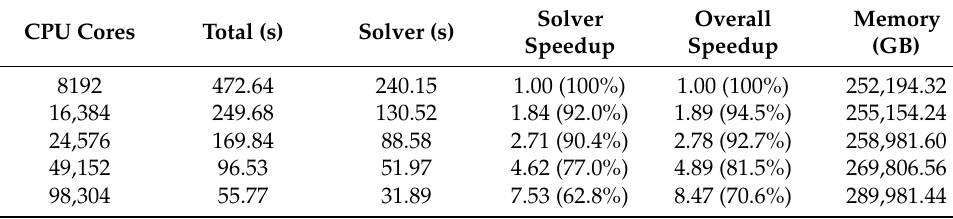
Figure 17. Example 8: scalability curve. Table 16. Summary of Example 9.